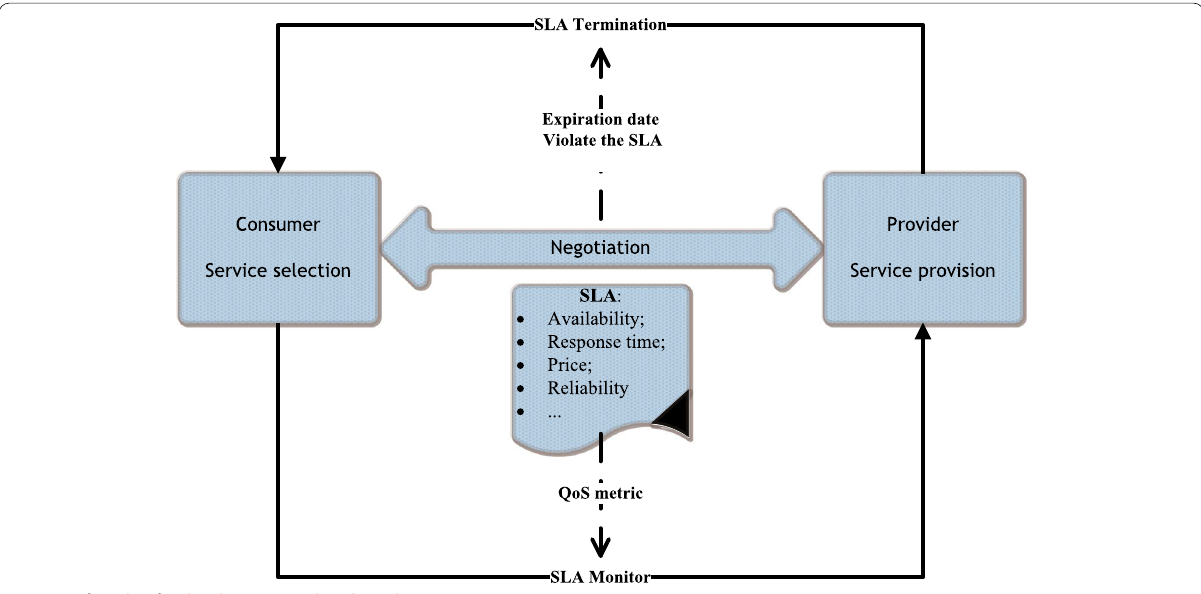
Fig. 1 Lifecycle of a cloud service trading-based